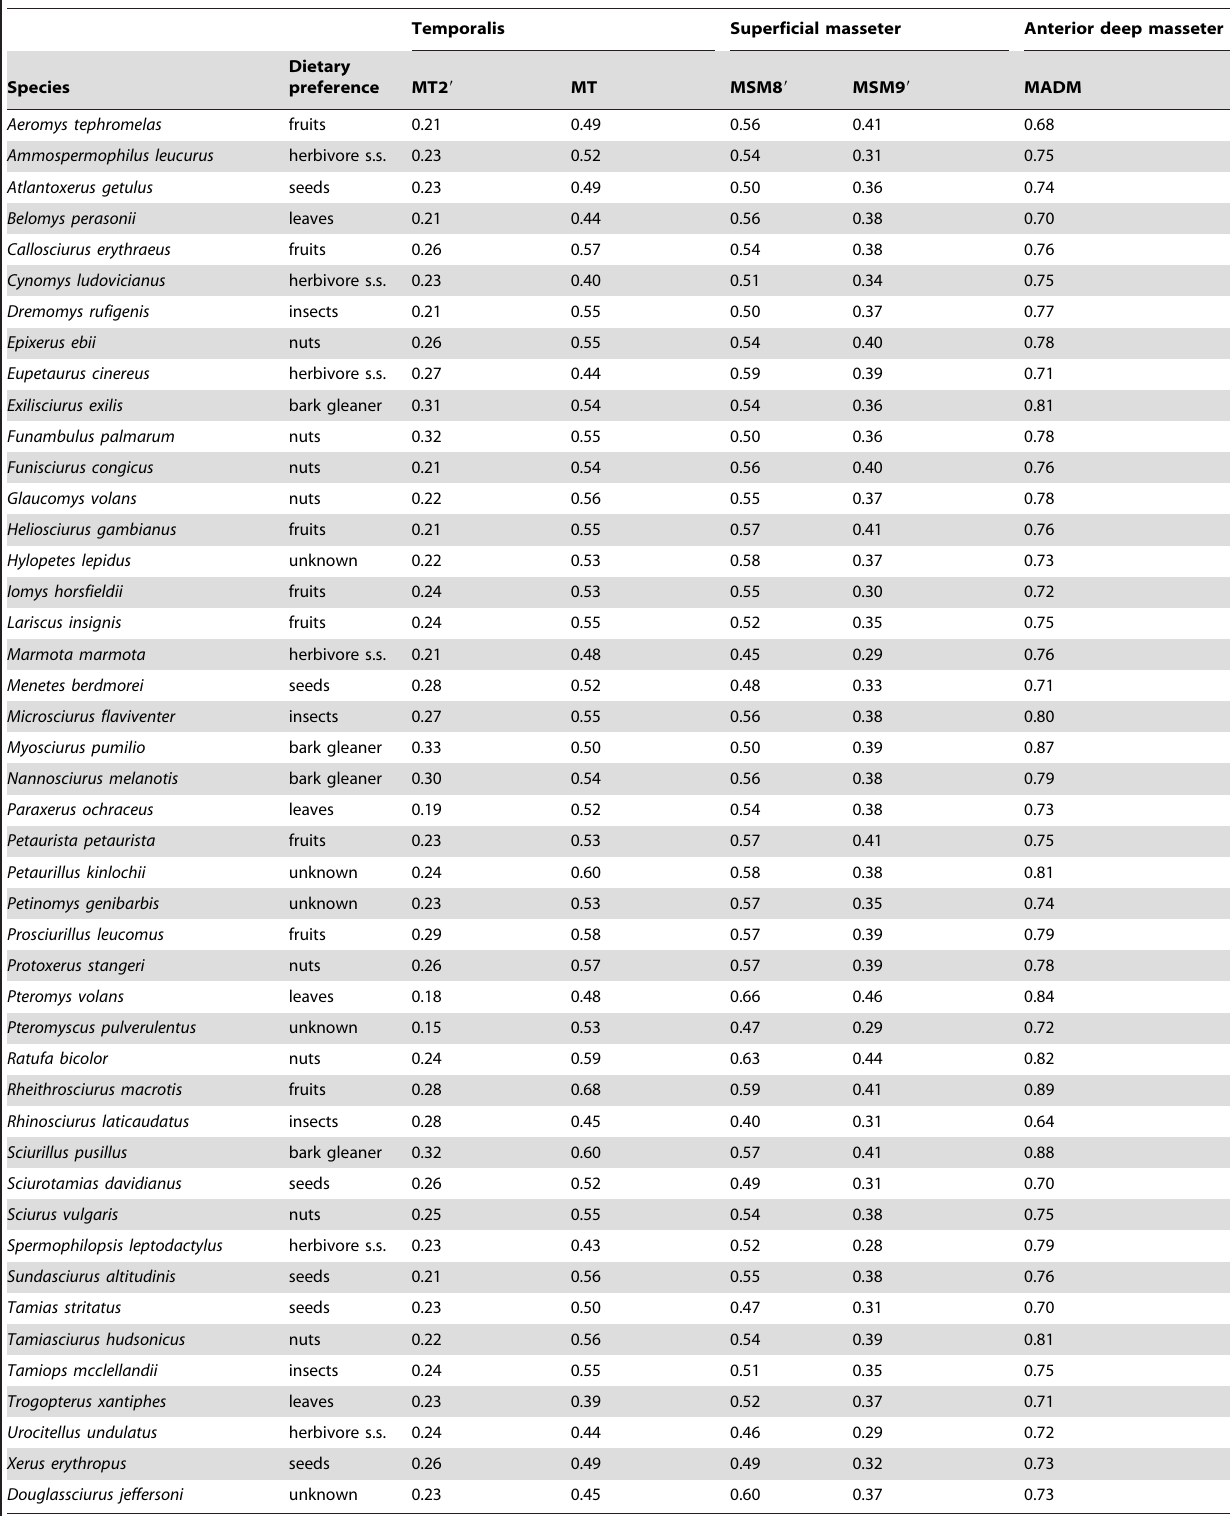
Table 1. Mechanical advantage of main mandibular muscles expressed as ratio of moment arms to incisor resistance arm.